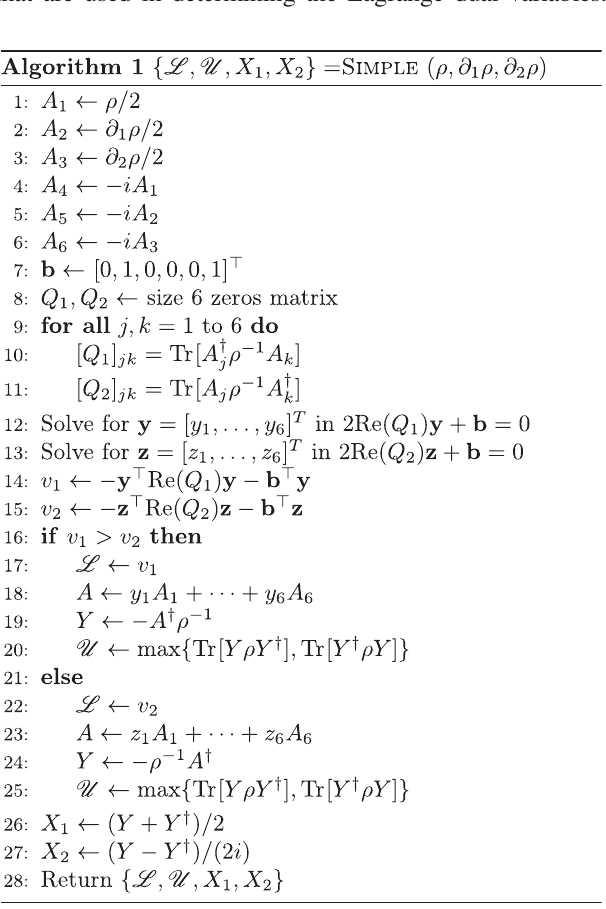
FIG. 1. Pseudocode to determine simple bounds to the two- parameter HCRB and its associated optimal measurement ob- servables X 1 and X 2 . Note that this algorithm depends only on the state ρ and its two derivatives ∂ 1 ρ and ∂ 2 ρ